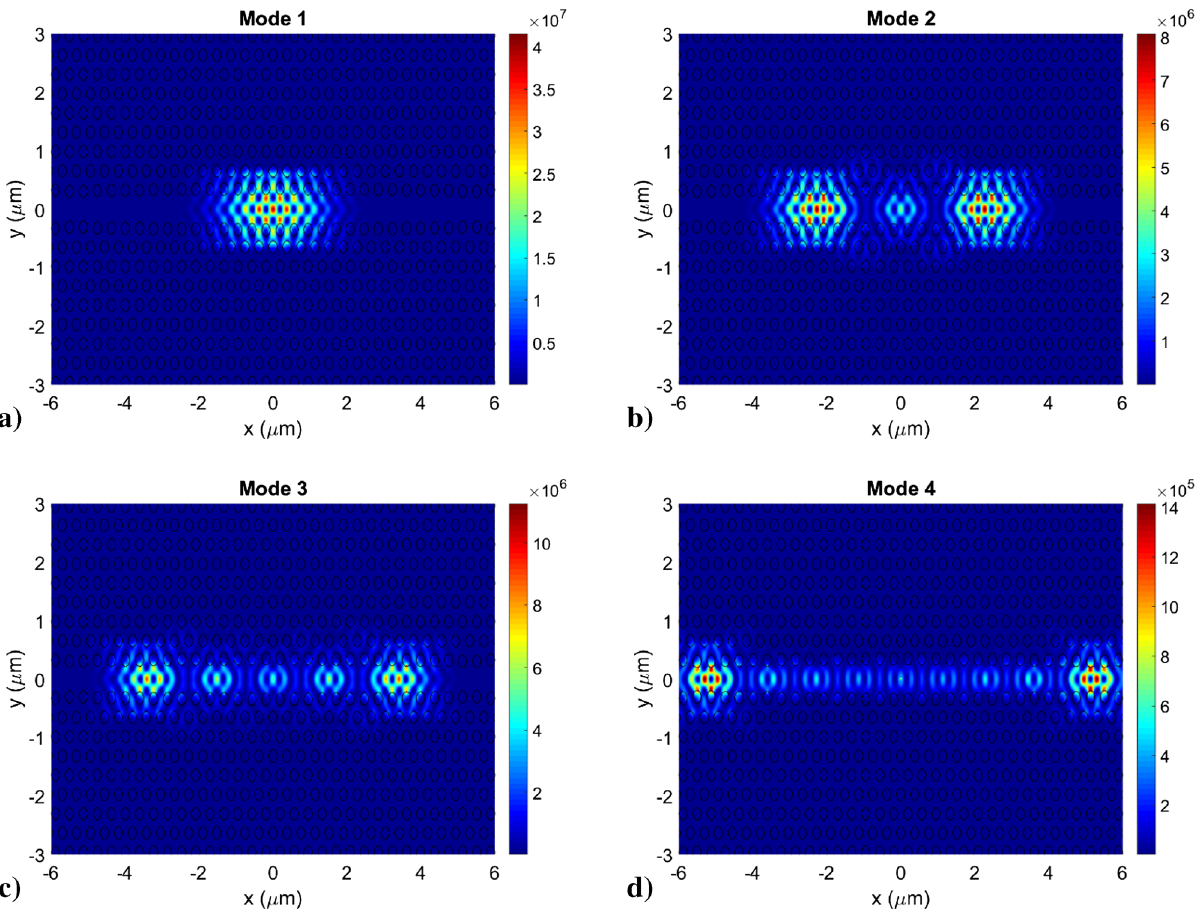
Figure 8. Electric field intensity plot in the xy plane of the first four optical modes confined in a 270 nm thick poly:Si DA PhC cavity. ( a ) Mode 1 (the fundamental mode) and higher order modes ( b ) Mode 2, ( c ) Mode 3 and ( d ) Mode 4.